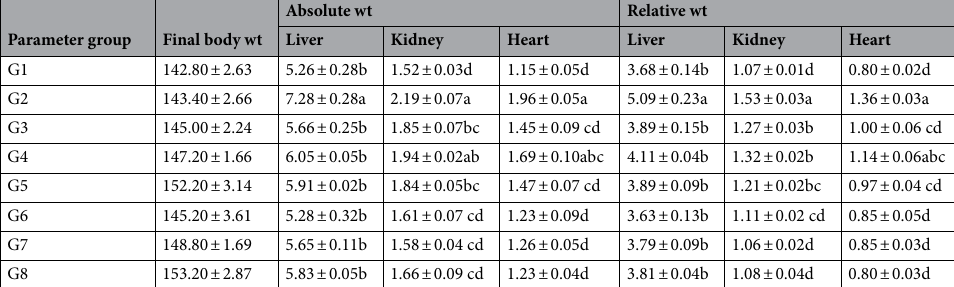
Table 2. The changes in the absolute and relative weight of different organs of normal control and different treated rat groups. G1 = control group, G2 = Paracetamol, G3 = Silymarin + Paracetamol, G4 = Chlorella vulgaris + Paracetamol, G5 = Chlorella vulgaris + Thiamine + Paracetamol, G6 = Silymarin, G7 = Chlorella vulgaris and G8 = Chlorella vulgaris + thiamine. Data are presented as means ± SEM (n = 6). Values having different superscripts within same column are significantly different ( p < 0.05).